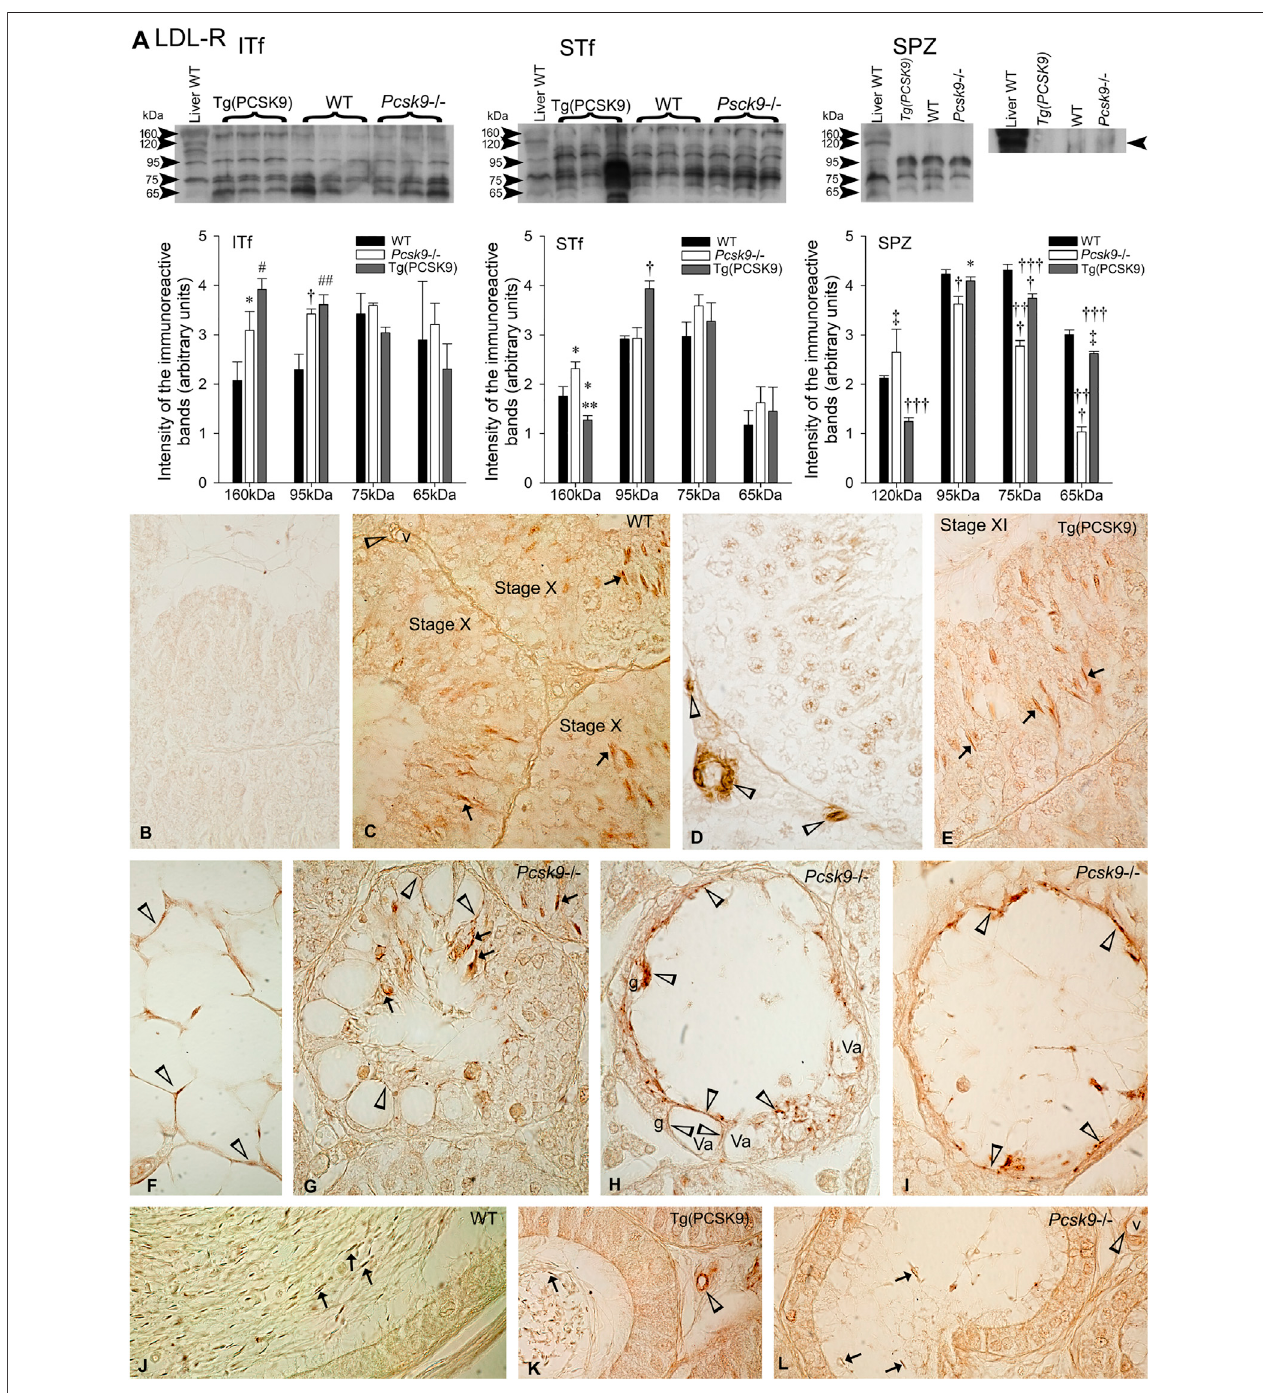
FIGURE 4 | LDL-R (A) LDL-R variations in ITf, STf and SPZ in Pcsk9 − / − , Tg (PCSK9) and WT mice: In ITf, 160- (* p < 0.05) and 95 kDa ( † p < 0.01) LDL-R levels signi fi cantly increased in Pcsk9 − / − mice compared to WT; in Tg (PCSK9) mice, the increase in 160- ( # p < 0.02) and 95 kDa ( ## p < 0.002) LDL-R levels is signi fi cant comparedtoWT.InSTf,160 kDalevelssigni fi cantlyincreasein Pcsk9 − / − mice( p p < 0.05vs.WT).InTg(PCSK9)mice,160 kDaLDL-Rsigni fi cantlydrops(** p < 0.005 vs. Pcsk9 − / − and* p < 0.05vs.WT)andtheupsurgein95 kDalevelsissigni fi cant( † p < 0.01)comparedto Pcsk9 − / − andWT.InSPZ,theincreasein120 kDalevels( ‡ p < 0.03) and the decrease in 95- ( † p < 0.01), 75- and 65- ( ††† p < 0.0001) are signi fi cant compared to WT. In Tg (PCSK9) mice, 120 kDa LDL-R signi fi cantly decreases ( ††† p < 0.0001vs. Pcsk9 − / − andWT);thedifferencein95 kDaissigni fi cant(* p < 0.05vs. Pcsk9 − / − );75 kDalevelssigni fi cantlydifferfrom Pcsk9 − / − ( ††† p < 0.0001)andWT ( † p < 0.01)and65 kDalevelsdiffersigni fi cantlycomparedto Pcsk9 − / − ( ††† p < 0.0001)andWT( ‡ p < 0.03).Thevaluesarethemean±SEM; n =3perexperimentalgroup. (B – L) Immunolocalisation ofLDL-R: (B) Sections exposedtothe second antibody without the fi rst showed no reaction product. Theacrosome ofelongated spermatids